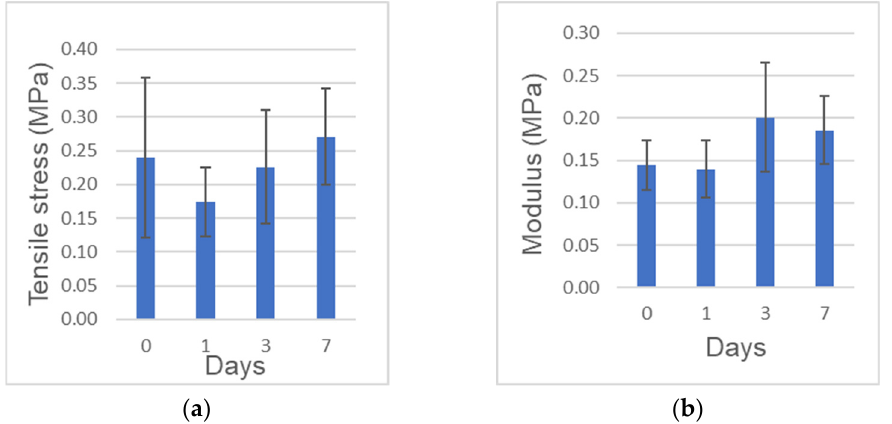
Figure 2. Mechanical tests. ( a ) Tensile strength. ( b ) Elastic modulus at 20–30%. n =